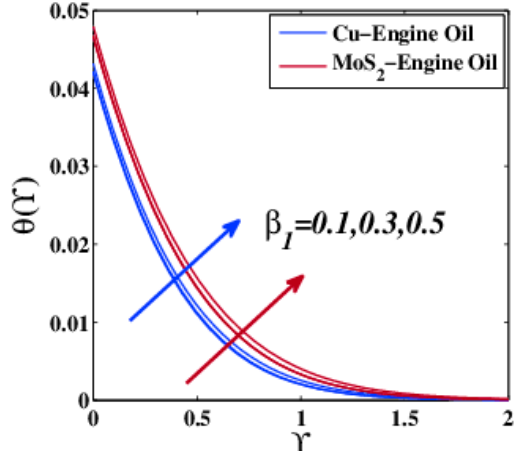
Figure 5. The effect of 𝛽 (cid:2870) on velocity variation 𝑓 (cid:4593) (𝛶).